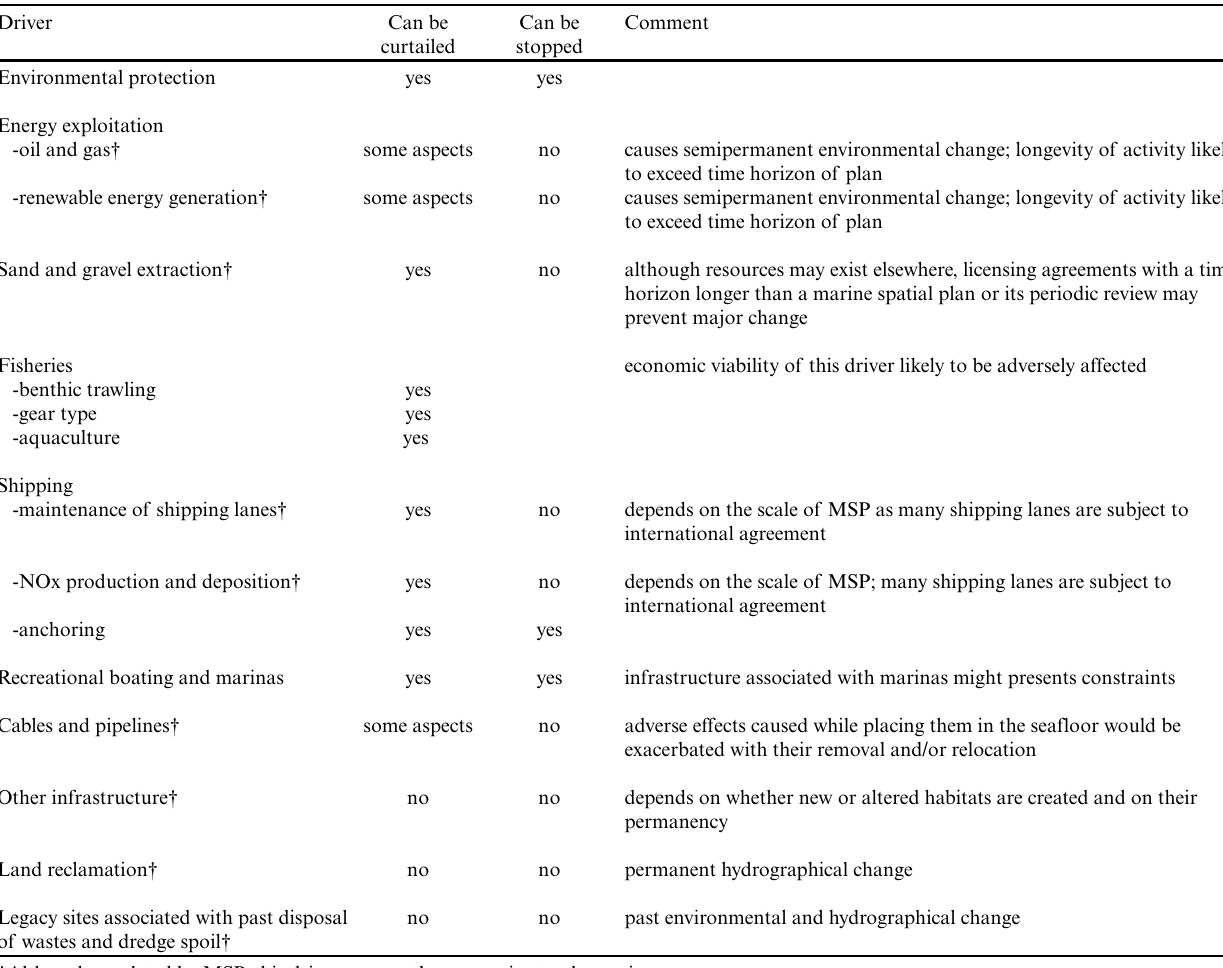
Table 3 . Capacity for change in driver activity following marine spatial planning (MSP)